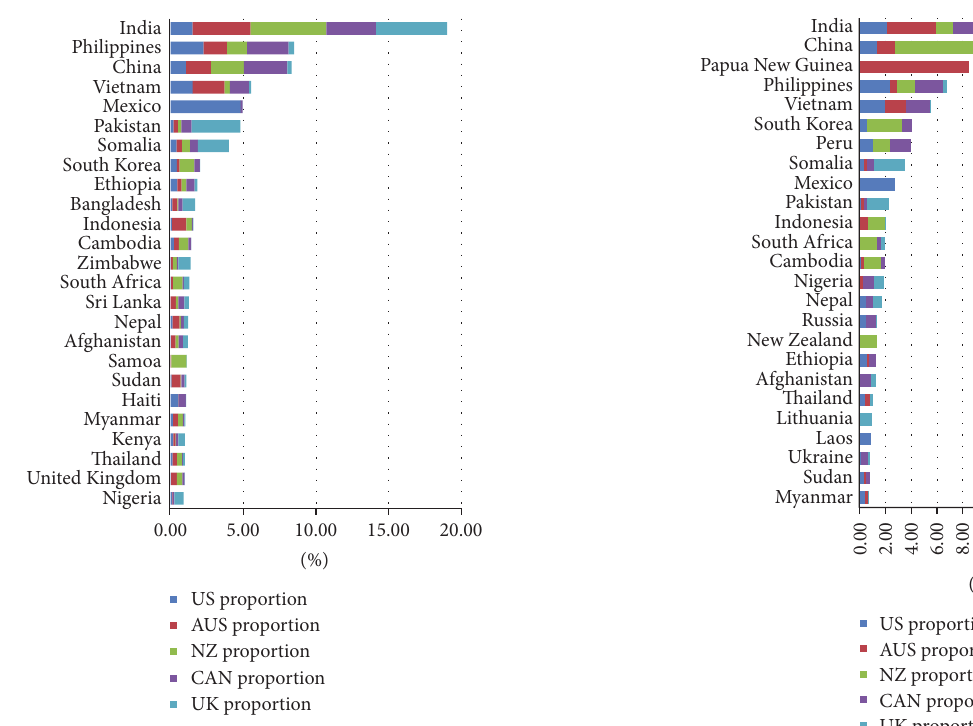
Figure 3: Combined averages of MDR TB cases,